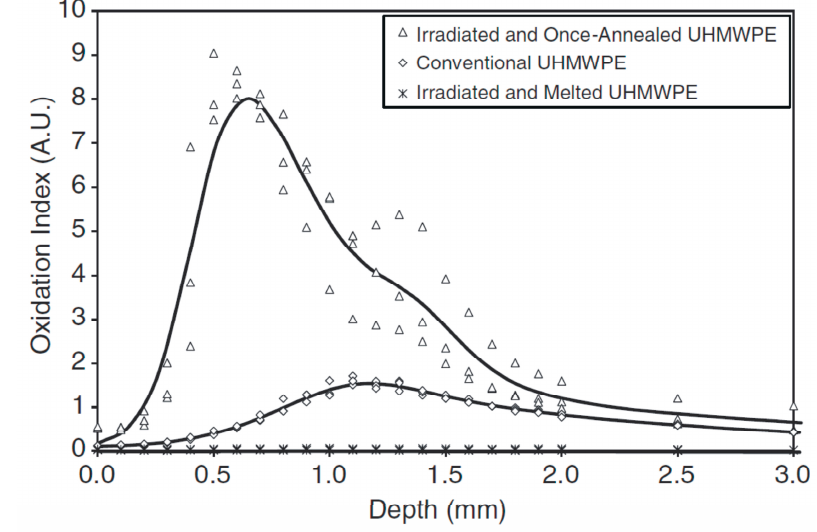
Figure 5. Oxidation profiles of conventional UHMWPE (gamma-inert sterilized, 25–40 kGy), irradiated and once-annealed UHMWPE (CrossfireTM Stryker-Howmedica-Osteonics; Rutherford, NJ, USA), and irradiated and melted UHMWPE (DurasulTM Zimmer, formerly Centerpulse; Austin, TX, USA) after 128 weeks of real-time aqueous aging at 40 °C. Reproduced with permission from [71].